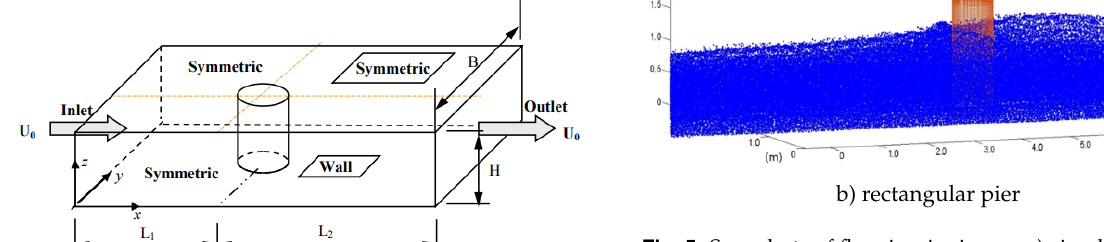
Fig. 5. Snapshots of flow impinging on a) circular pier, and